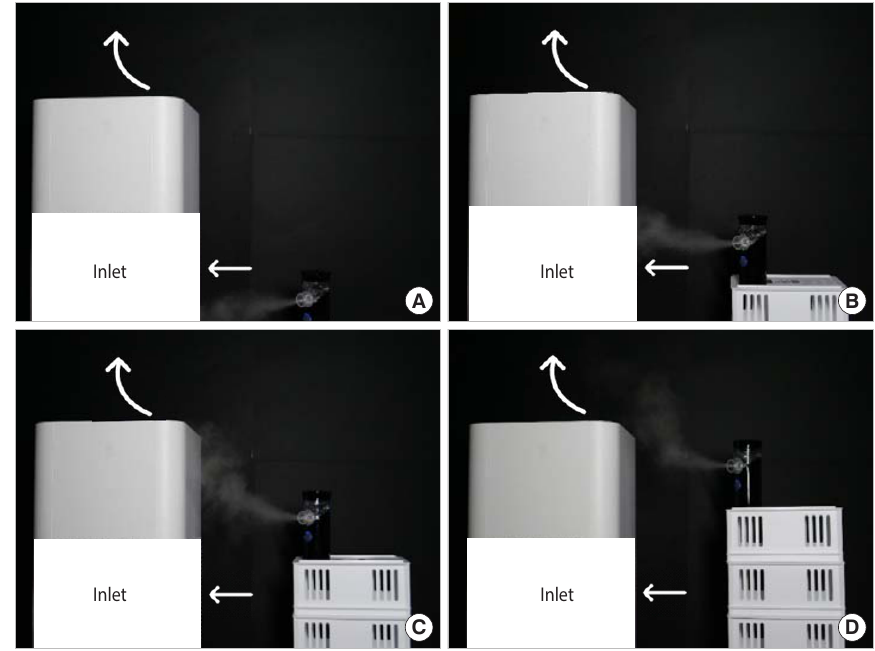
Figure 1. Pilot experiment result of visualized air flow in terms of height of source (A) floor level, (B) 8 cm, (C) 16 cm, and (D) 24 cm from floor level.